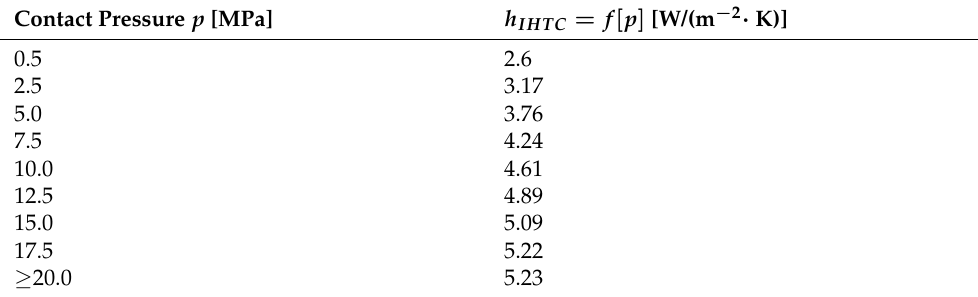
Figure 3. Geometries and initial temperatures of the cross-die cup tooling and blank. Length units are in [mm]. Table 3. Pressure-dependent interfacial heat transfer coefficient h IHTC = f [ p ] between the tooling and